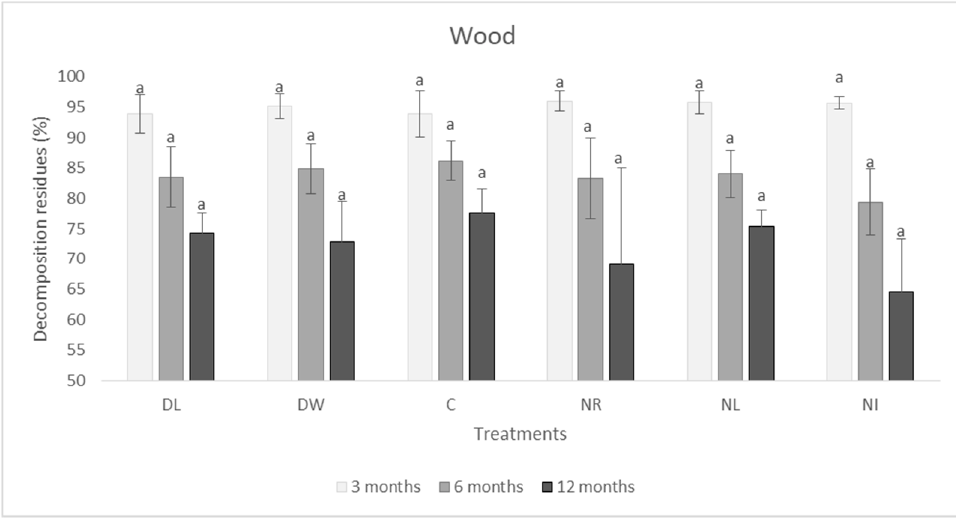
Figure 4. Effect of organic matter manipulation experiments with different DIRT treatments on wood degradation rate after 3, 6 and 12 months: The letters represent significant differences between treatments during the given period ( n = 4).